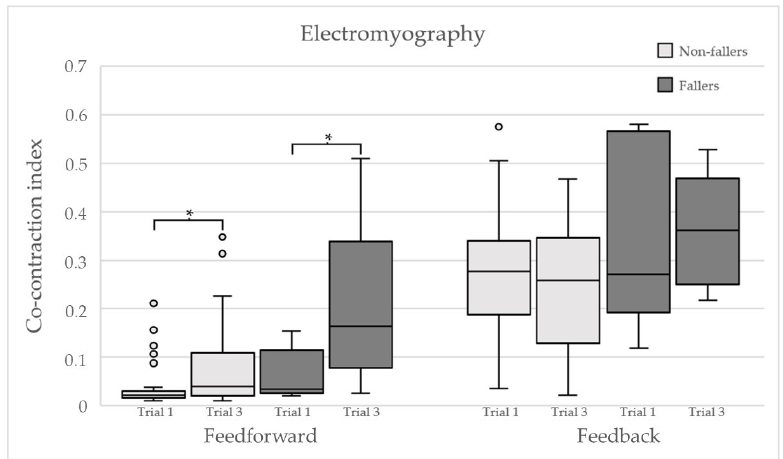
Figure 3. Co-contraction index for both groups during the feedforward and the feedback period for both trials. An asterisk indicates significant inter-trial difference for the group, tested with the Wil- coxon signed-rank